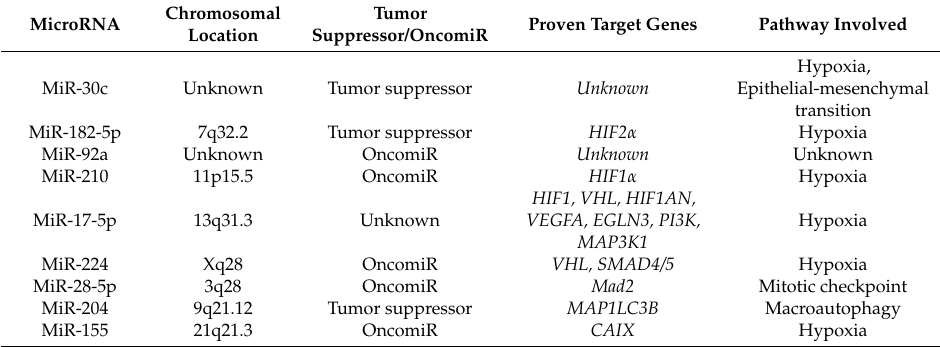
Table 1. MicroRNAs associated with Von Hippel–Lindau (VHL) in clear cell renal cell carcinoma (RCC). mesenchymal transition (EMT) Chromosomal Tumor Proven Target Genes Pathway Involved MicroRNA Location Suppressor/OncomiR Hypoxia, MiR-30c Unknown Tumor suppressor Unknown Epithelial-mesenchymal transition MiR-182-5p Tumor suppressor HIF2 α OncomiR